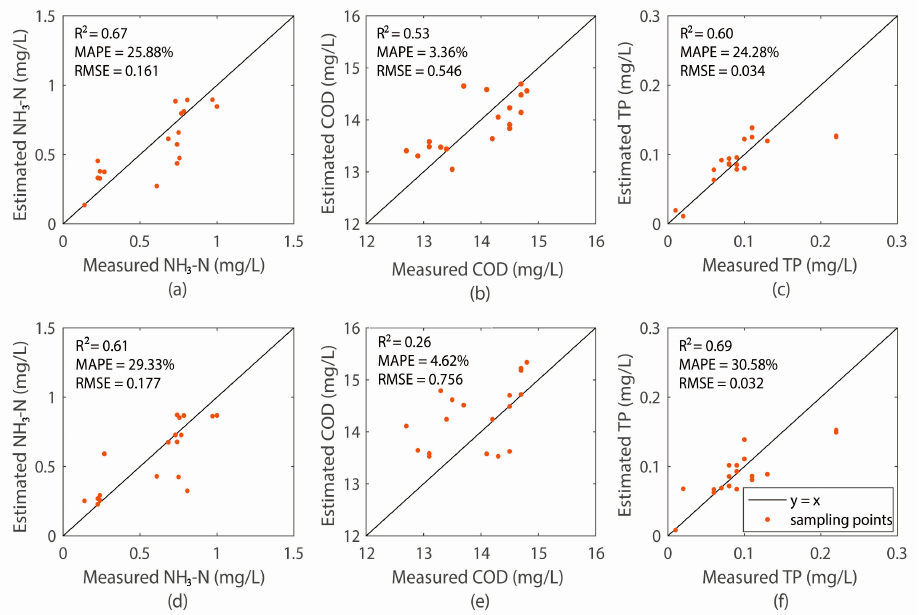
Figure 7. Accuracy assessment results of NH 3 -N, COD and TP estimated by the statistical regression models using super-resolution images ( a – c ) and original images ( d – f ). The X -axis is measured data, and the Y -axis is estimated data. ( a , b , d , f ) used the cubic function model; ( c , f ) used the reciprocal model.